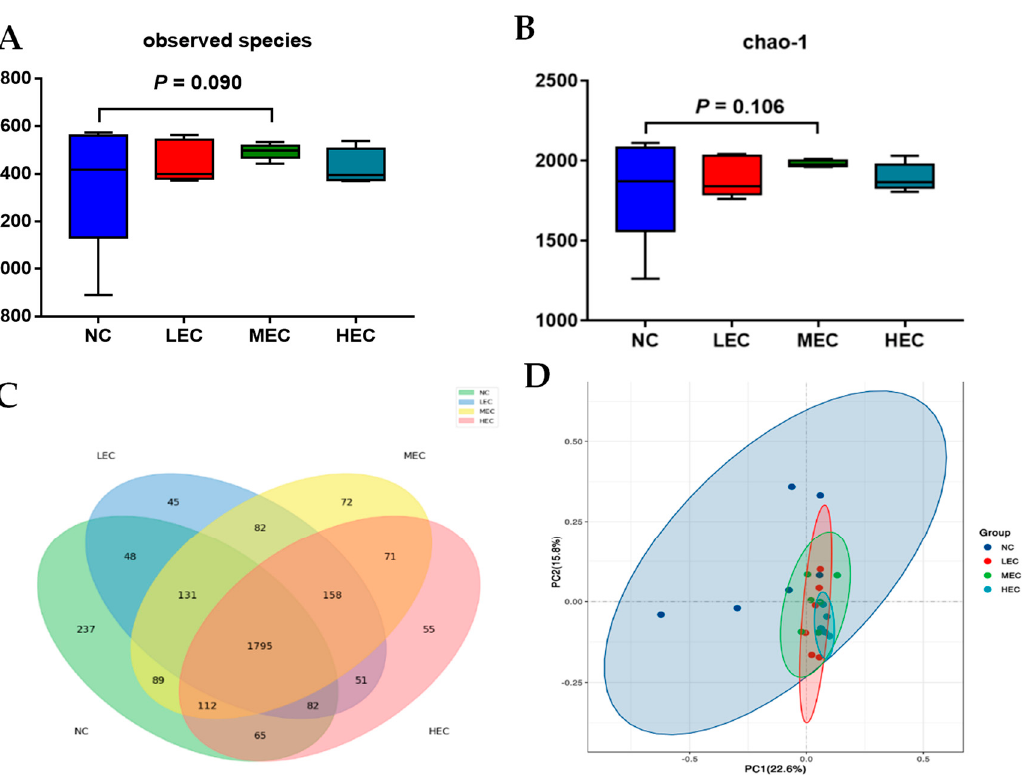
Figure 1. Summary of the microbial community from the fecal samples of piglets in experiment 2 ( n = 6). ( A ) is the Shannon index reflecting species diversity; ( B ) is the Chao − 1 index reflecting species diversity; ( C ) is a Venn diagram summarizing the number of common and unique observed taxonomic units (OTUs) in the microflora; and ( D ) is the PCoA plot based on weighted UniFrac distances.